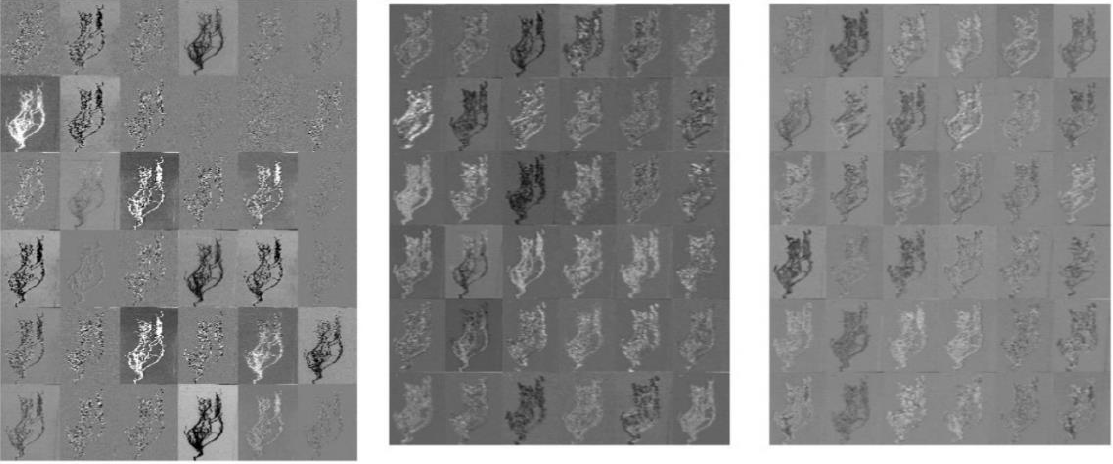
Figure 5. Activation maps of the input image from the DeepARRNet model.